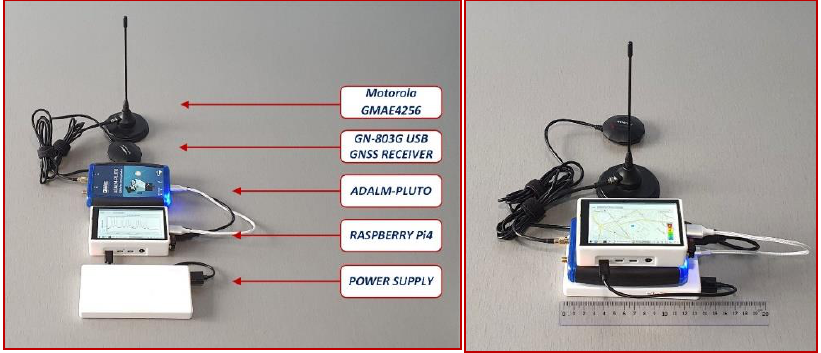
Figure 9. Portable sensor elements controlled with the Raspberry Pi.